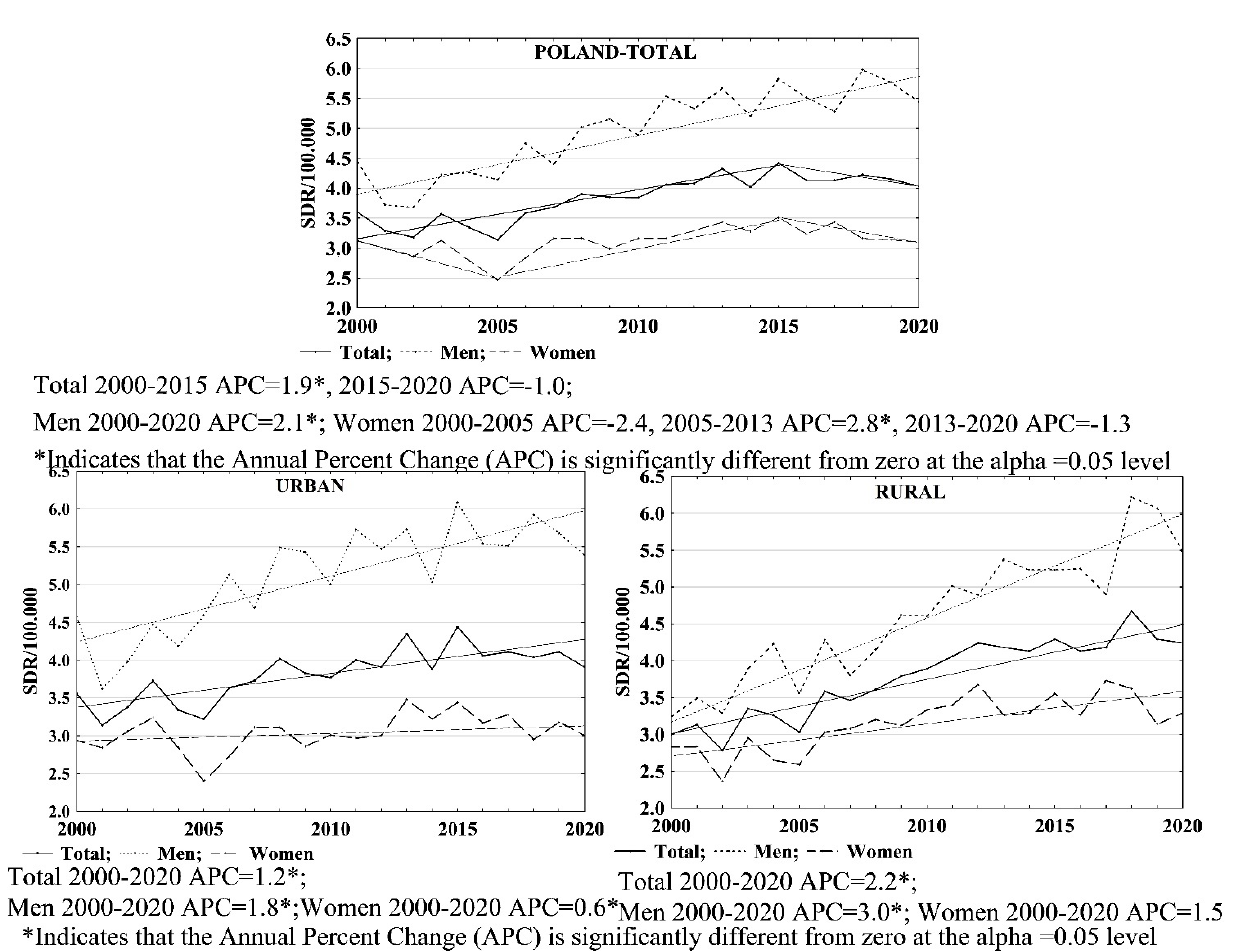
Figure 4. SDR due to skin melanoma by gender and place of residence in Poland in 2000–2020.